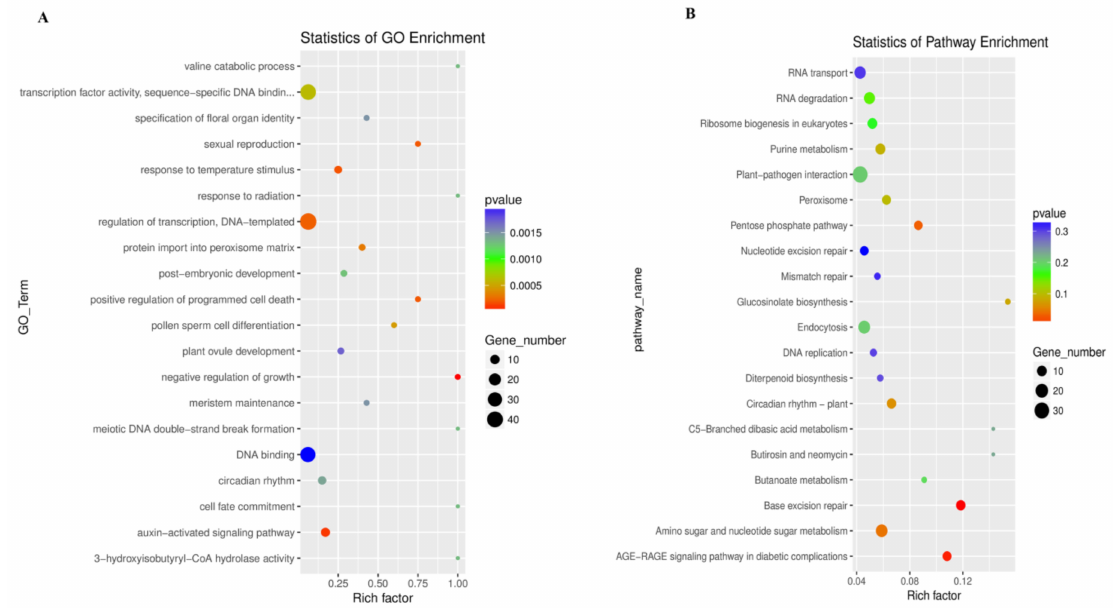
Figure 6. ( A ) Gene Ontology (GO) enrichment of the target genes; ( B ) Kyoto Encyclopedia of Genes and Genomes (KEGG) annotation for the target